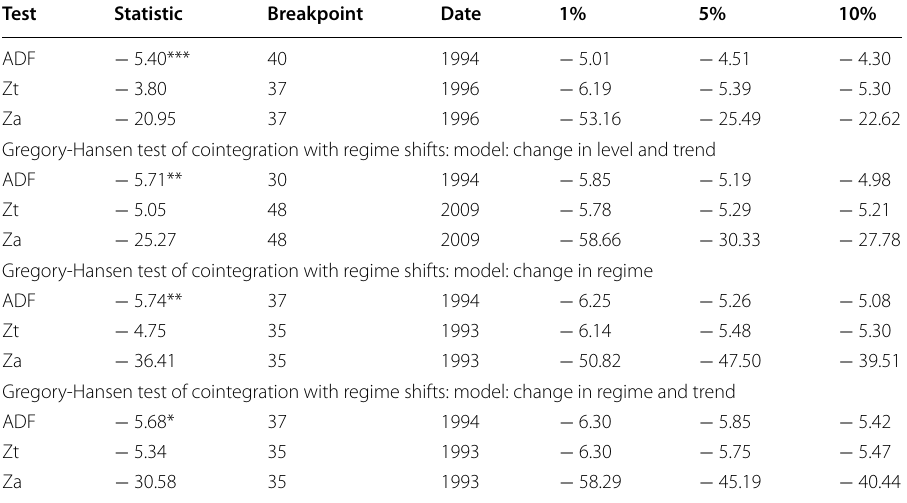
*, ** and *** denote statistical significance at 10%, 5% and 1% levels